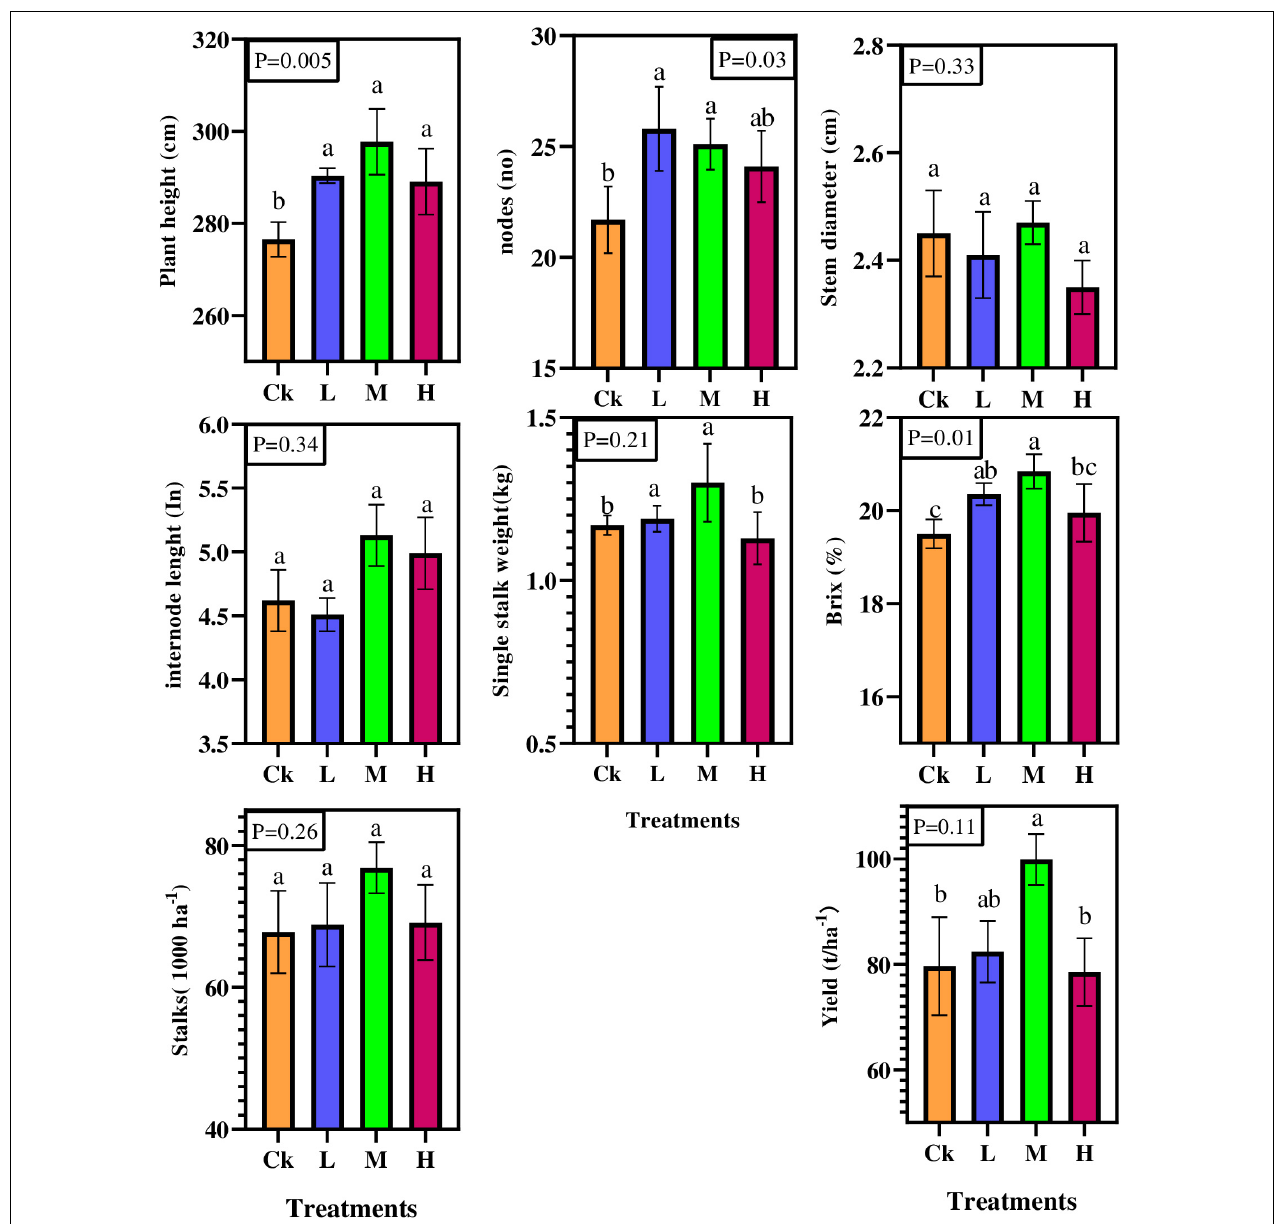
FIGURE 1 | Sugarcane morphological and yield characteristics under four different nitrogen fertilizer applications. CK; no fertilizers, L = (Low, 100 kg ha − 1 ) M = (Medium, 150 kg ha − 1 ) H = (High, 200 kg ha − 1 ).